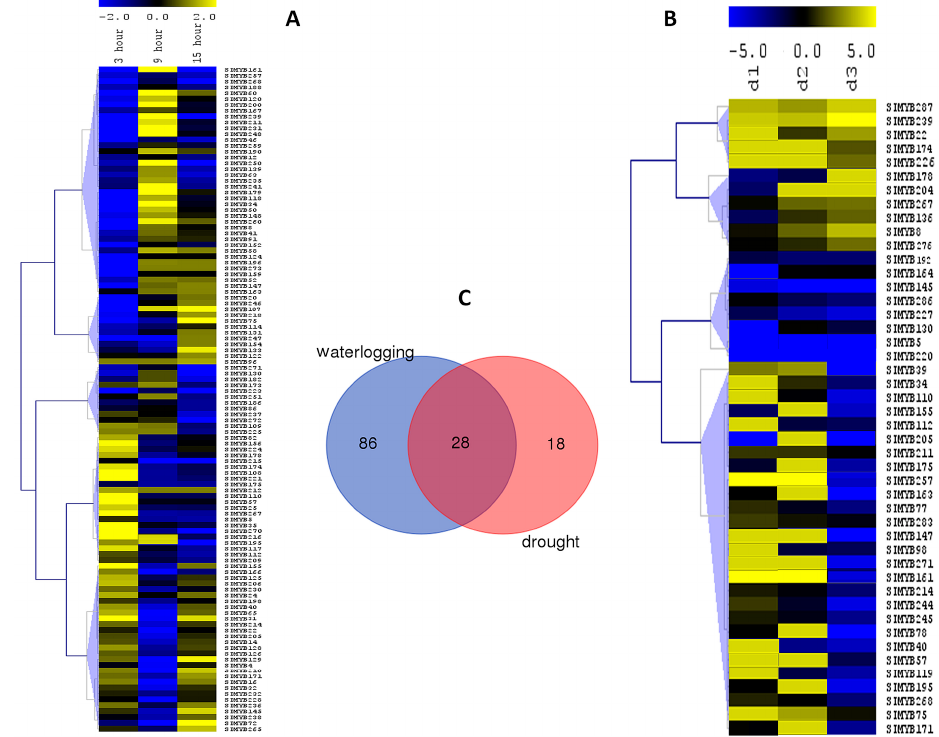
Figure 5. Transcriptome profiling of MYB gene expression under waterlogging and drought stress. ( A ) Heatmap displaying expression changes of differentially expressed MYB genes in sesame plants stressed for 3 h, 9 h and 15 h of waterlogging compared with the control; ( B ) Heatmap displaying expression changes of differentially expressed MYB genes in sesame plants stressed for 3 days (d 1 ), 7 days (d 2 ), and 11 days (d 3 ) of drought compared with the control; and, ( C ) Venn diagram depicting the shared and stress-specific differentially expressed genes between waterlogging and drought.